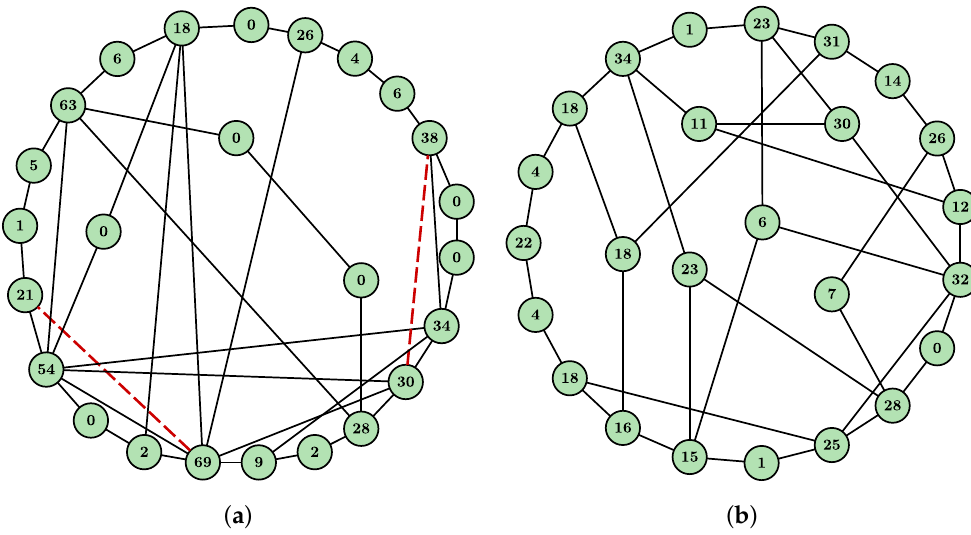
Figure 6. Optimization of topology shown in Figure 5: ( a ) addition of two edges; and ( b ) minimization of the maximum Wiener